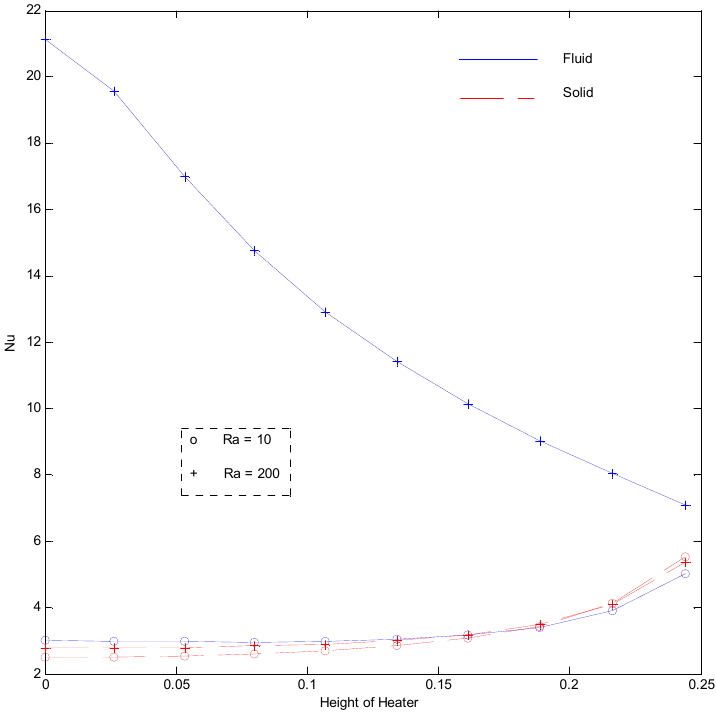
= 5, HH = 25%, Kr = 1, Rd = 0 for strip at x =